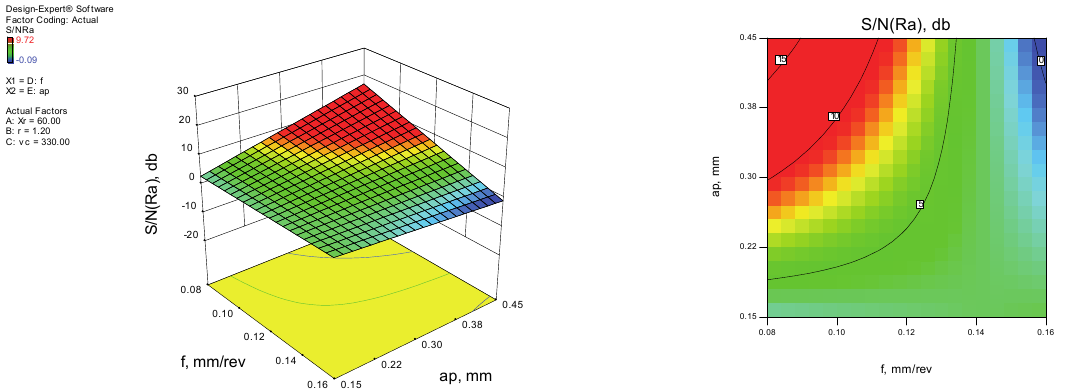
Fig. 6. 3D plot and contour for the response surface for: Effect of ( f × ap ) on the S/N ( Ra